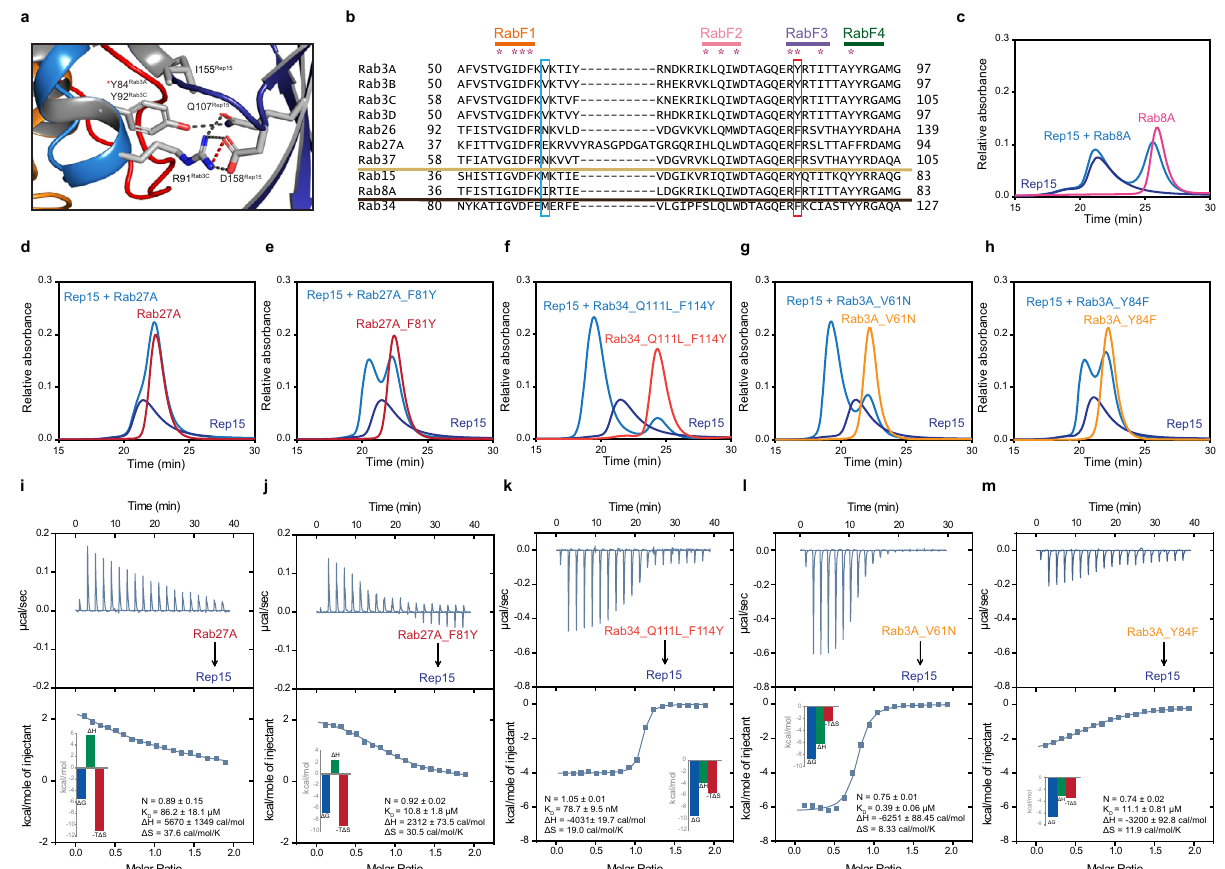
Fig. 6 Tyrosine within the RabF3 motif of Rab3 determines speci fi city towards Rep15. a The zoom-in on the binding interface of Rep15:Rab3C GppNHp_Q222H_10-227 (bovine) complex structure. * indicates the position of equivalent tyrosine in Rab3A. b The sequence alignments of different evolutionary similar human Rab proteins clearly show that most of the Rep15 interacting residues are conserved except for the residues indicated in the sky blue and red bar. Residue V61 lies next to the binding interface whereas Y84 is interacting with crucial Q107 Rep15 and D158 Rep15 . c – h The Rep15 protein (110 µ M, blue), the different Rabs (121 µ M, orange) and the mixture of both (sky blue) were subjected to an analytical size exclusion chromatography (aSEC) and tested for complex formation. Rab8A and Rab27A do not form a stable complex. However, Rab27A F81Y mutant shows some complex formation with the Rep15. V61N mutation of Rab3A and F114Y mutation or Rab34 does not affect its interaction. with Rep15. i – m Binding af fi nities were measured by titrating the Rab GTPase (500 µ M) to full-length Rep15 (50 µ M). Integrated heat peaks were fi tted to a one-site-binding model yielding the binding stoichiometry (N), the enthalpy ( Δ H), the entropy ( Δ S), and the dissociation constant (K D ). For Rab27A, Rab27A F81Y and Rab34 Q111L_F114Y_237 titration to full-length Rep15, 600 µ M Rab is titrated to 60 µ M Rep15. N.D. denotes not detected. The data are representative of at least three